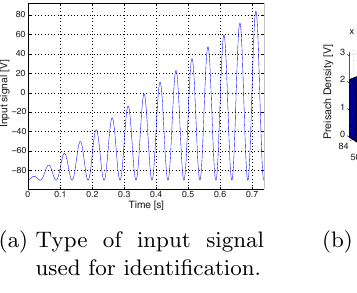
Figure 4: Partition of Preisach plane with center weighting masses.